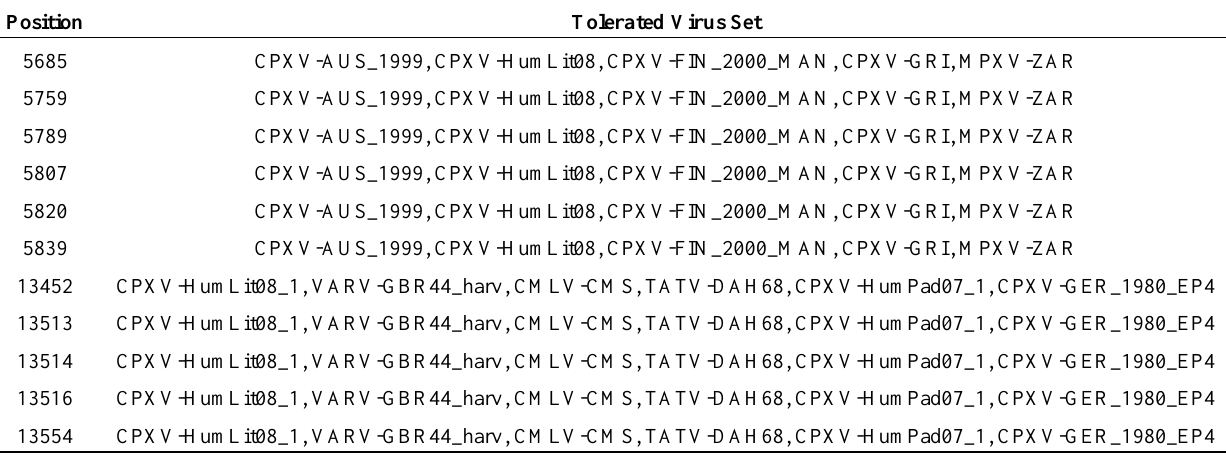
Table 2. Positions of SNPs where all VACVs are identical and all other sequences are different, with Tolerance of